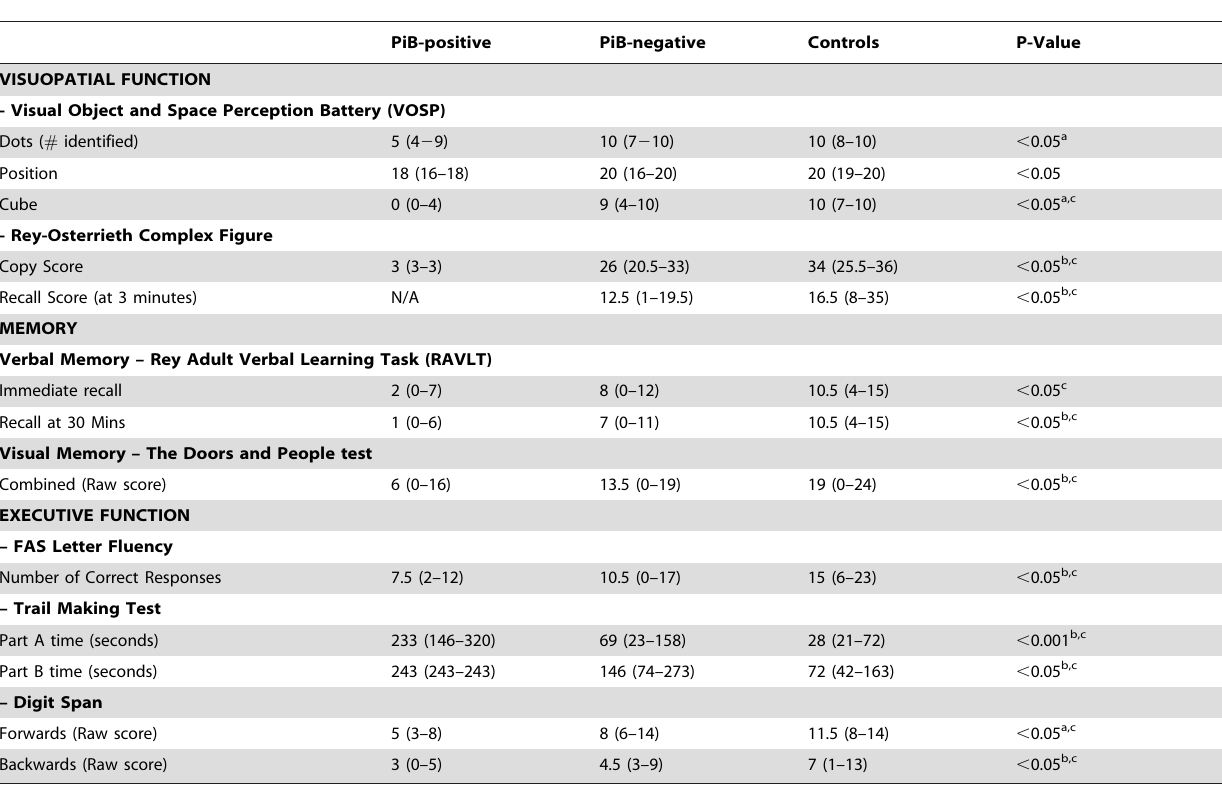
Table 5. Neuropsychological profile of CBS patients according to PiB